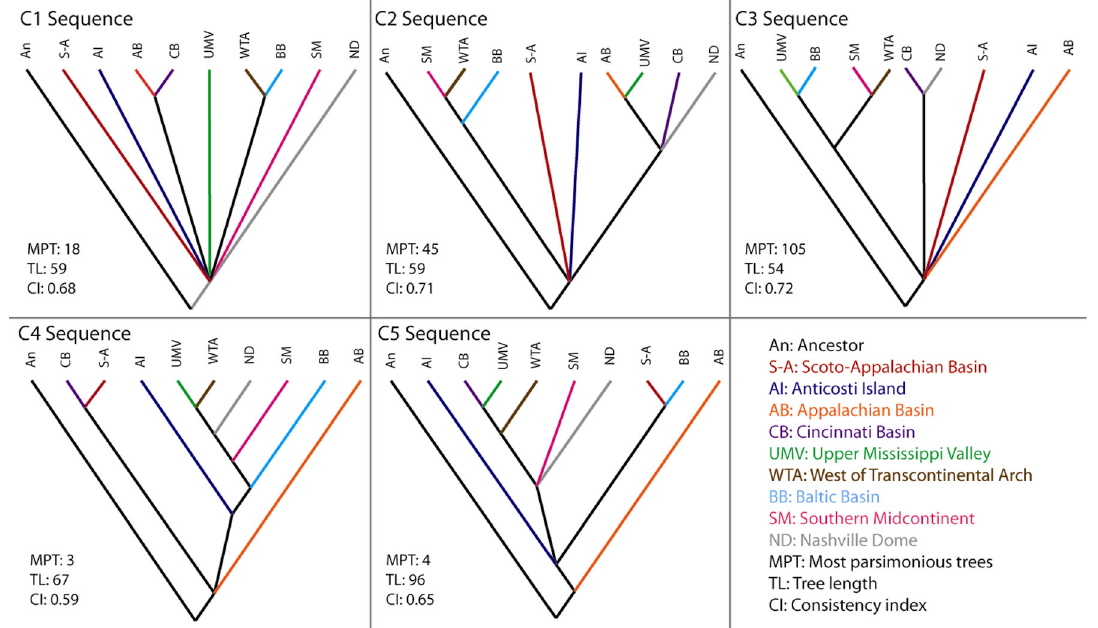
Fig. 2. Parsimony Analysis of Endemicity areagrams. Areas group together in sister-area relationships based on the number of shared endemic taxa; the nested patterns present indicate hierarchical relationships of shared endemic taxa, which is a different metric than overall similarity (similarity values in supplementary materials archive: http://dx.doi.org/10.6084/m9.figshare.1194963). Shifts in area relationships between time slices indicate dispersal between those